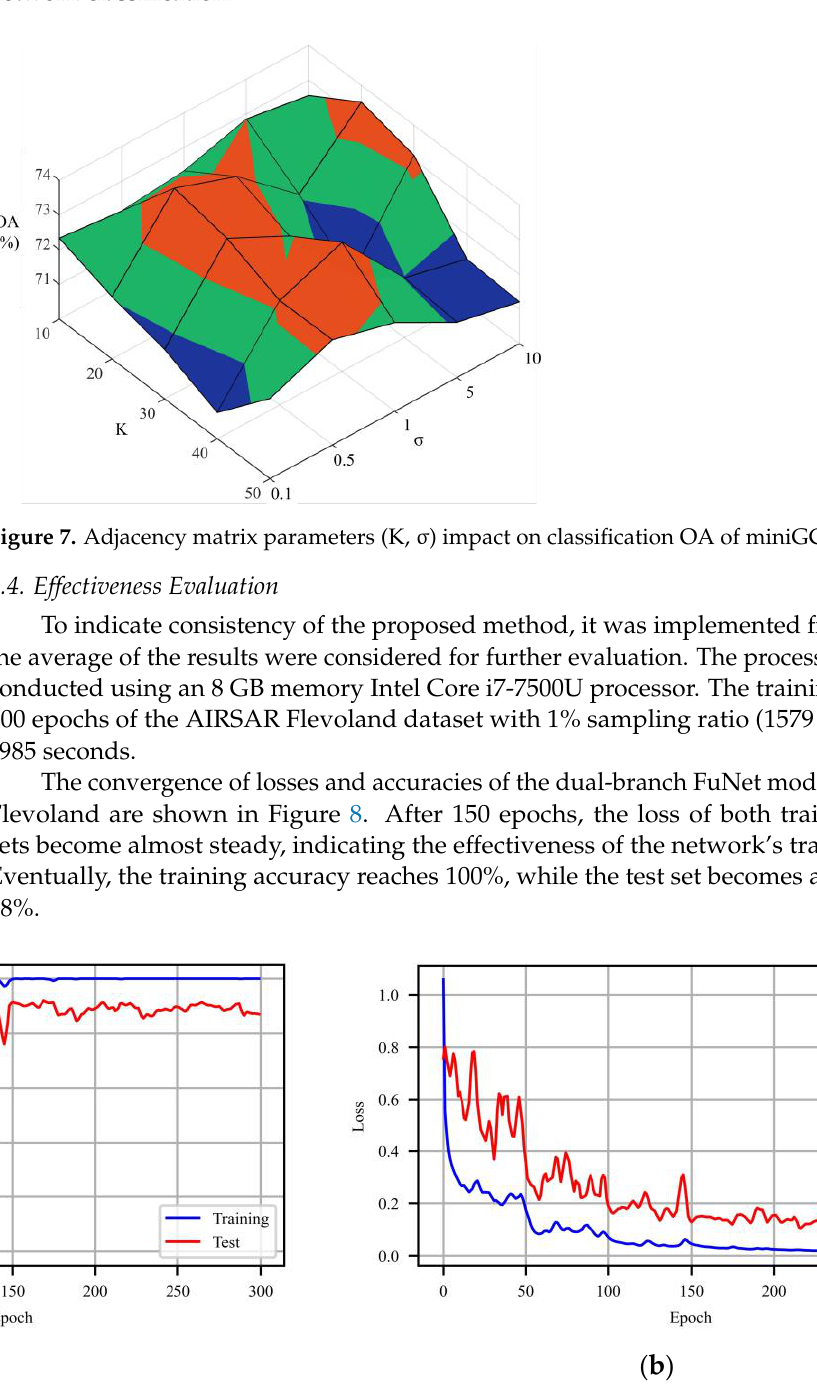
Figure 8. ( a ) Accuracy and ( b ) loss curves of the dual-branch FuNet